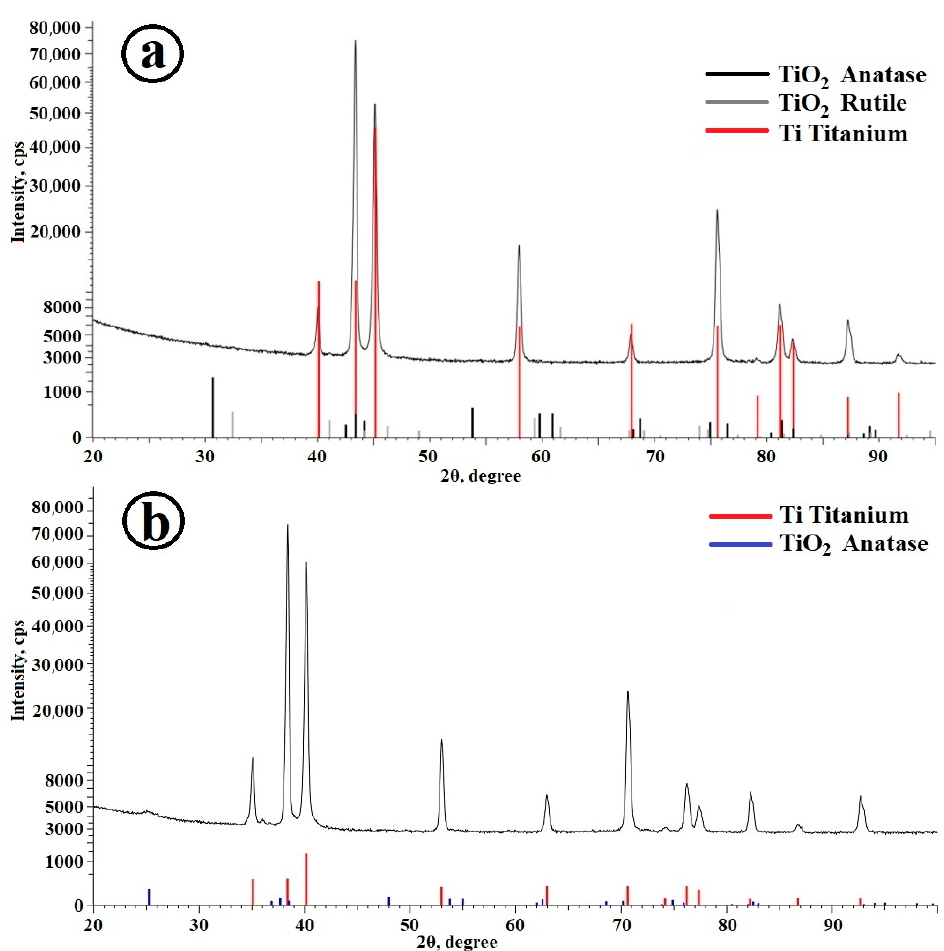
Figure 2. XRD patterns of the sample with a TiO 2 coating: ( a ) before calcination; and ( b ) after calcination at 400° C.